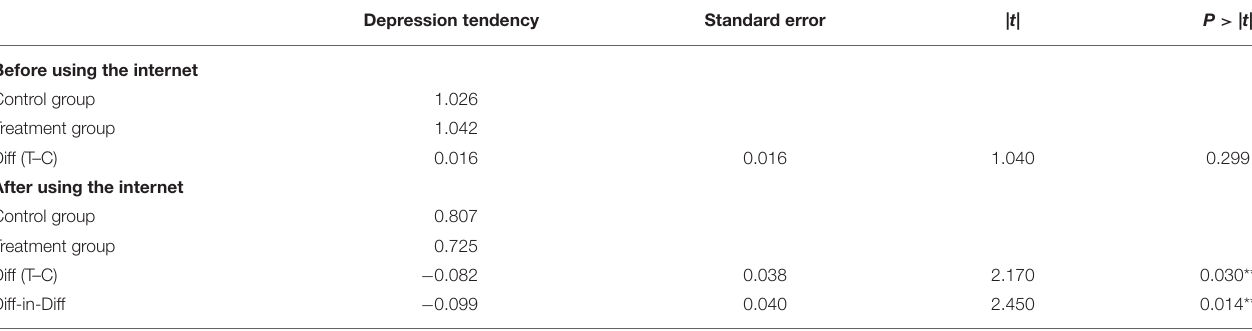
TABLE 7 | Difference-in-difference (DID) estimation for the effect of Internet use on mental health.